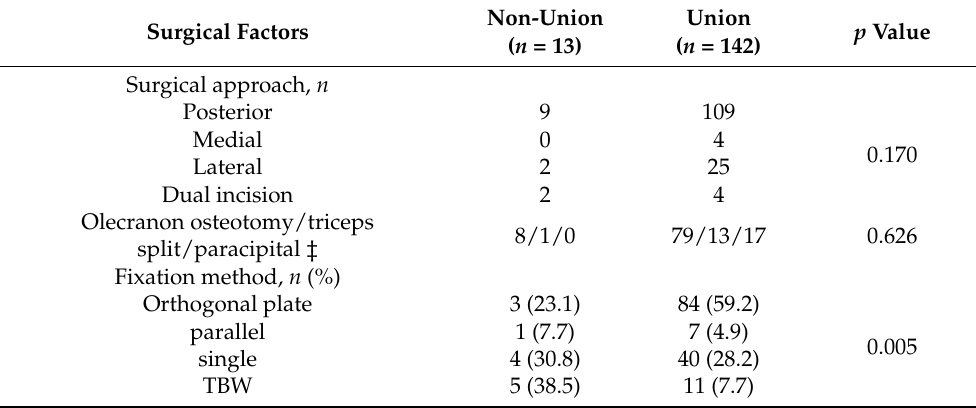
Table 4. Comparison of surgical approaches and fixation methods between non-union patients and union